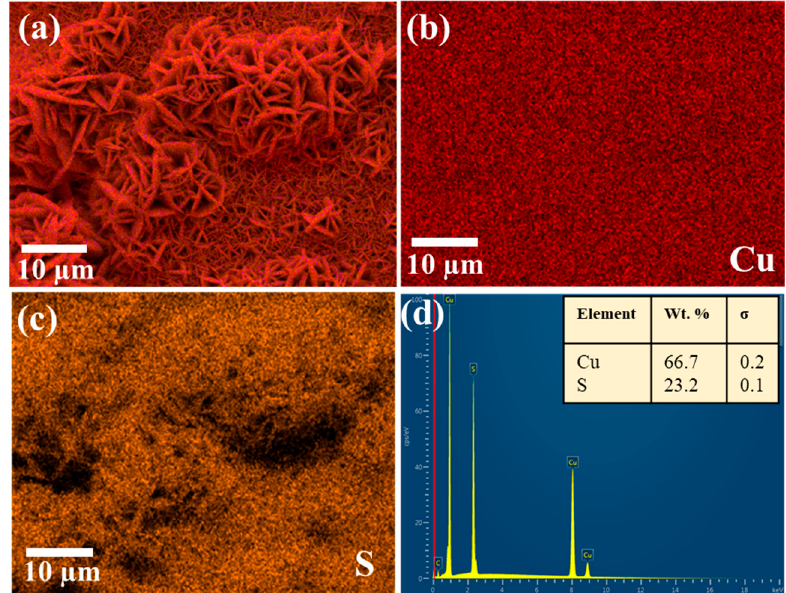
Figure 4. EDS mapping of Cu and S elements on the ( a – c ) surface of CuS nanocrystalline branches. ( d ) EDS spectra.